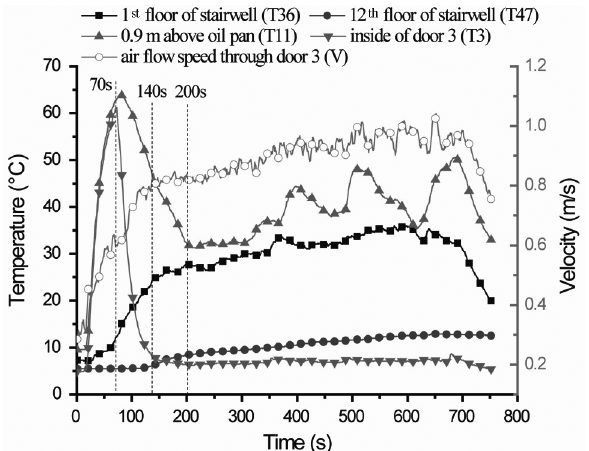
Fig. 10. Comparison of the fire room temperature T3 and T11, stairwell temperature T36 and T47, airflow speed V in case B4 (pool size: 25 cm, top vent: open, door 3 size: 0.24 m first floor of stair; T47: the twelfth floor of stair; T3: 5 cm away from Door 3, 0.6 m high; T11: 0.9 m above the oil pan; V: air flow speed through door